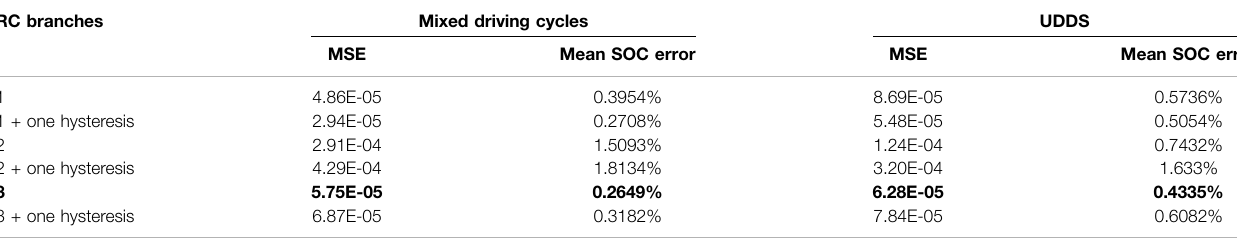
TABLE 8 | H-in fi nity fi lter with varying RC branches.